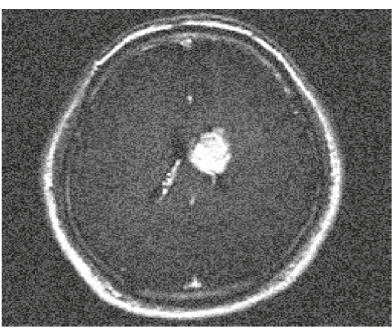
Figure 3: Grayscale PSD estimate.